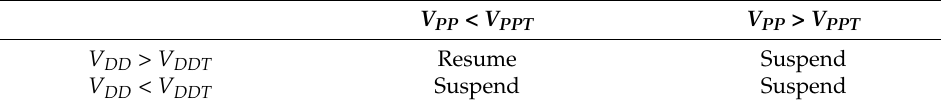
Figure 3. Building blocks of the proposed CP circuit system. Table 2. Operation condition of the main CP against V DD and V PP